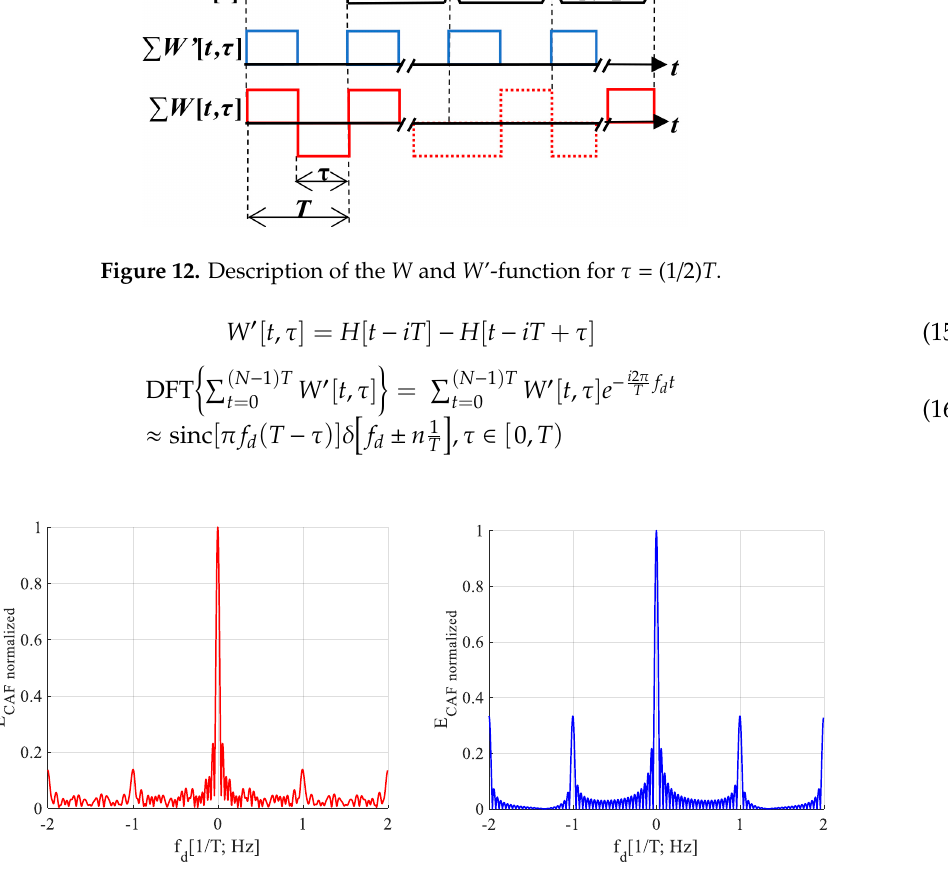
Figure 13. Splitting of the false peak ( left ) and the main peak ( right ) in the Doppler shift domain for τ = (1/4) T .